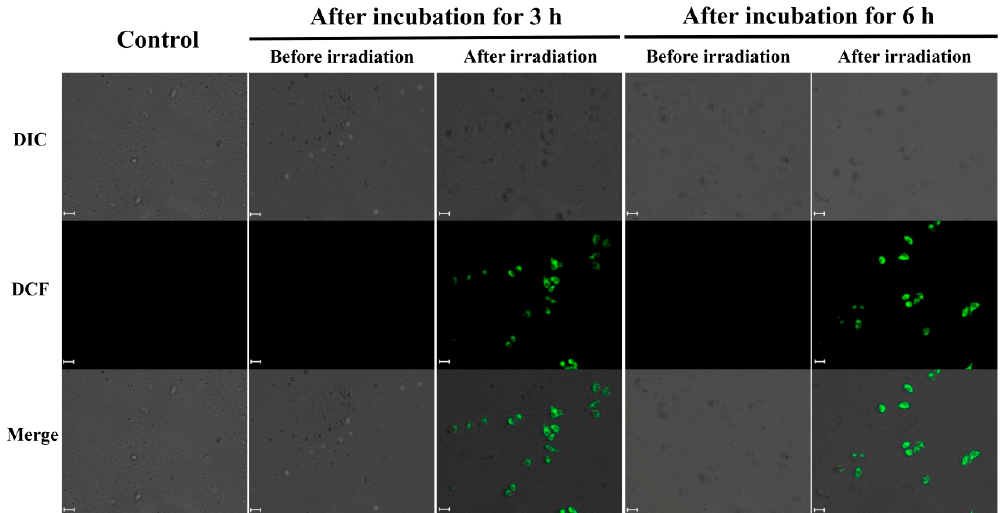
Figure 3. Singlet oxygen production detected by fluorescence of DCF in HeLa cells exposed to DOX/5-ALA-loaded A-PPG micelles before and after irradiation with 635 nm light (60 mW/cm 2 ). The differential interference contrast (DIC) channel, 2,7-dichlorofluorescein (DCF) channel and merged images are presented from left to right. All scale bars represent 20 μ m.